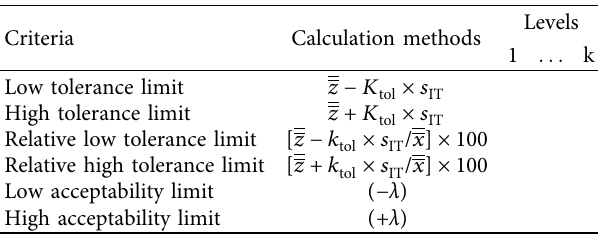
Table 5: Modes of calculation of accuracy profile parameters.